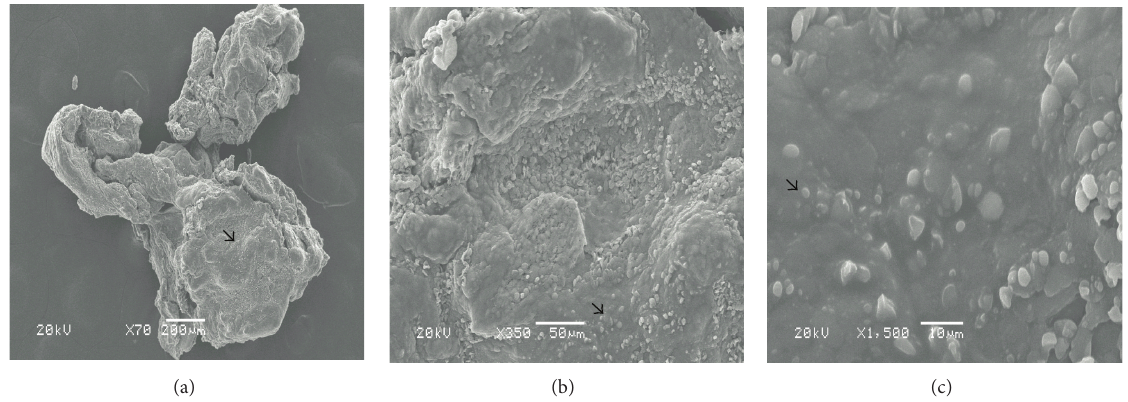
Figure 1: (a) Scanning electron micrograph of middle ear tissue covered with biofilm. Arrows indicate the extracellular material connected to the bacteria. The specimen was removed from a patient undergoing surgery for nonsuppurative chronic otitis media ((b) and (c) higher magnifications of same pictures).